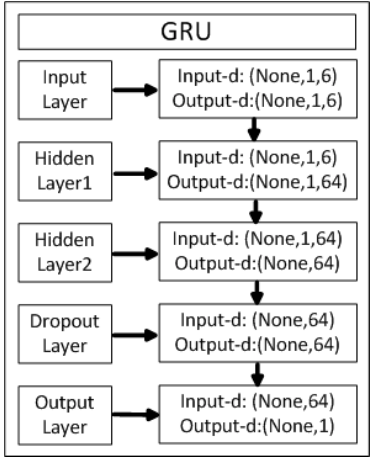
Figure 5. Model dimension conversion diagram.